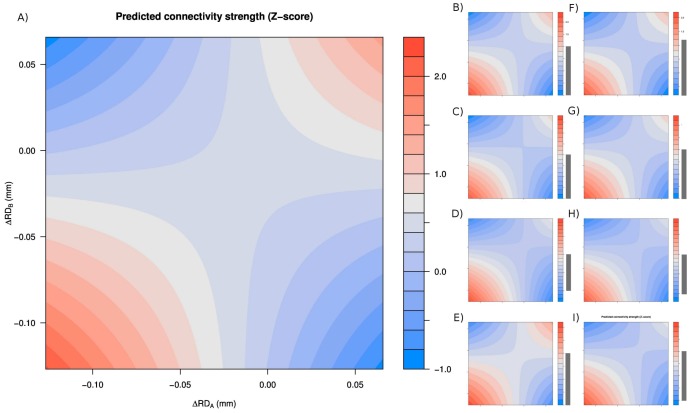
Filled contour plots visualizing the Regional Displacement Interaction (RDI) effect: how the predicted connectivity strength (color-coded) changes depending on the simultaneously varying values of  and , in case of no nuisance regression (A∶NOREG) and all investigated first-level nuisance regression methods, i.e., NOREG+M6 (E), WMSCF (B), COMPCORR (C), GSREG (D), WMSCF+M6 (F), COMPCORR+M6 (G), GSREG+M6 (H), and SAT36 (I).Vertical and horizontal axes of plots B-I are the same as those of plot A. Gray bars next to the legends indicate the (−1,1) interval to ease interpretation of color-coded Z-score values.